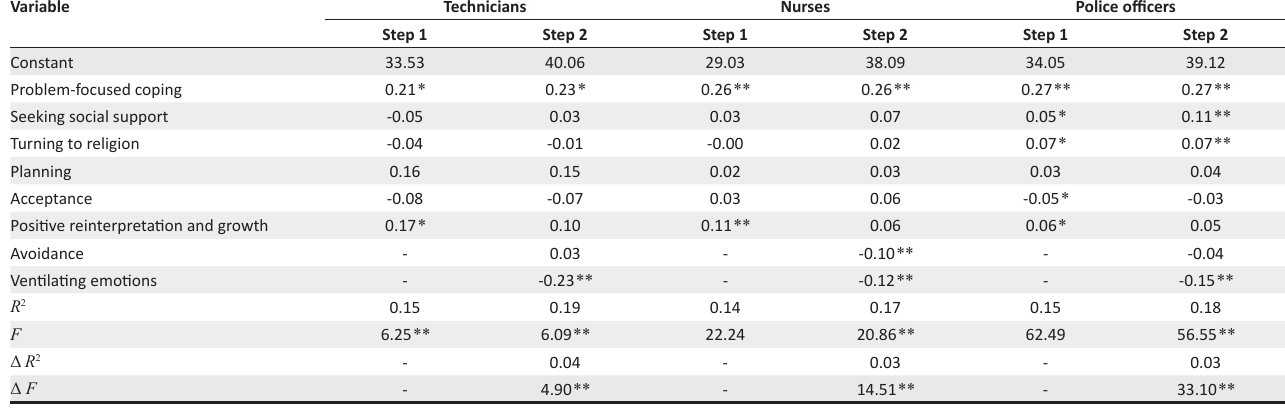
TABLE 6: Regression analyses with coping strategies as the independent variables and work engagement as the dependent variable.